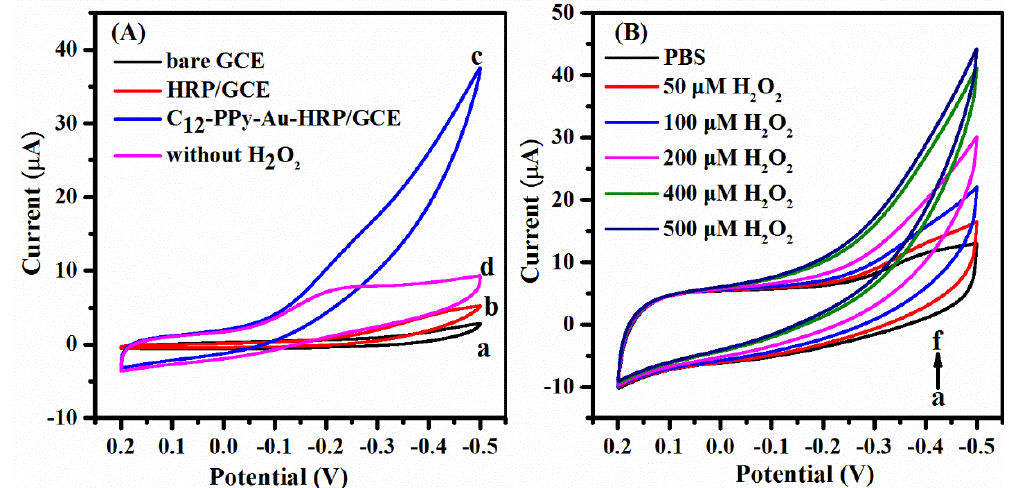
Figure 8. ( A ) Cyclic voltammograms of bare GCE ( a ), HRP/GCE ( b ), C 12 -PPy-Au-HRP/GCE in the presence of 100 µ M H 2 O 2 ( c ) and absence of H 2 O 2 ( d ) in 0.01 M PBS (pH = 7.0). ( B ) Cyclic voltammograms of C 12 -PPy-Au-HRP/GCE in 0.1 M PBS (pH = 7.0) containing different concentrations of H 2 O 2 , ( a – f ): 0–500 µ M H 2 O 2 . Scan rate: 50 mV · s –1 .